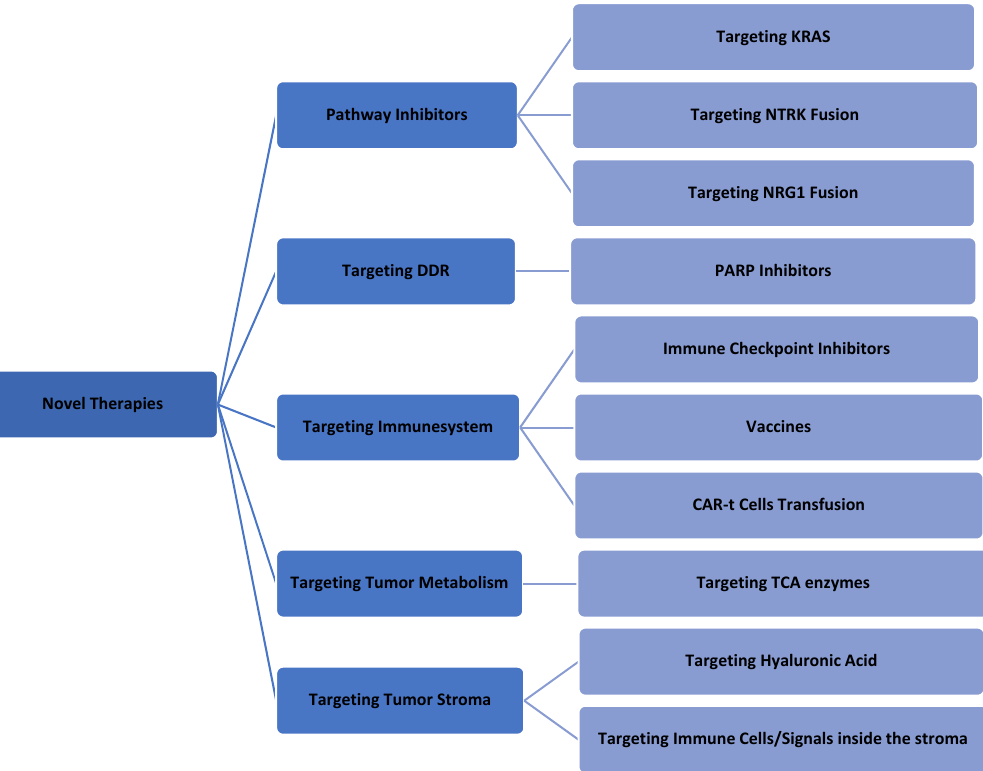
Figure 2. Summary of the last novel therapeutics in PDAC treatment.